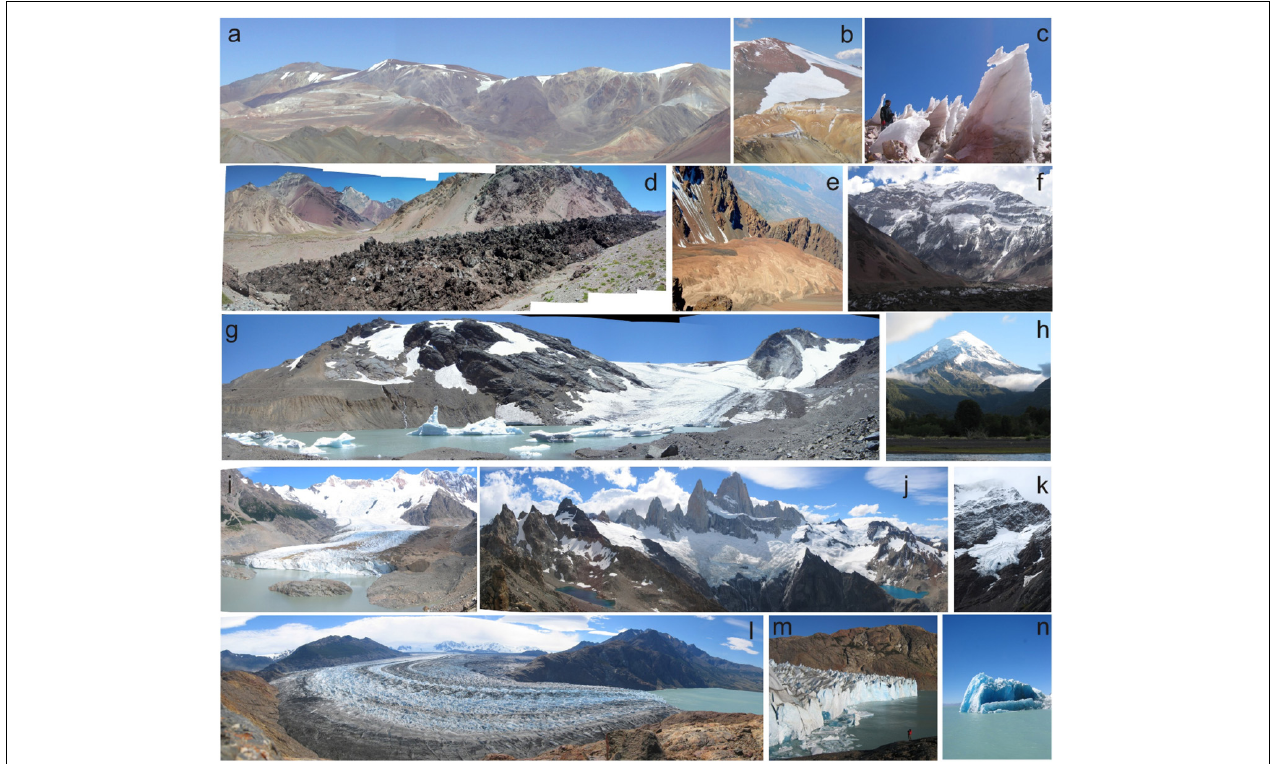
FIGURE 3 | Different types of ice masses that can be found in the Southern Andes. (a,b) snowfields/glacierets and mountain glaciers, Desert Andes, (c) ice penitent on mountain glacier, Desert Andes, (d) debris-covered, surging glacier, Central Andes, (e) rock glacier, Central Andes, (f) hanging and debris-covered glaciers, Central Andes, (g) calving valley glacier, Central Andes, (h) dome-shaped glacier, North Patagonian Andes, (i,j) valley and mountain glaciers, South Patagonian Andes, (k) hanging glacier, South Patagonian Andes, (l,m) outlet glacier and calving front, South Patagonian Andes, (n) iceberg from calving glacier front, South Patagonian Andes. Photos provided by